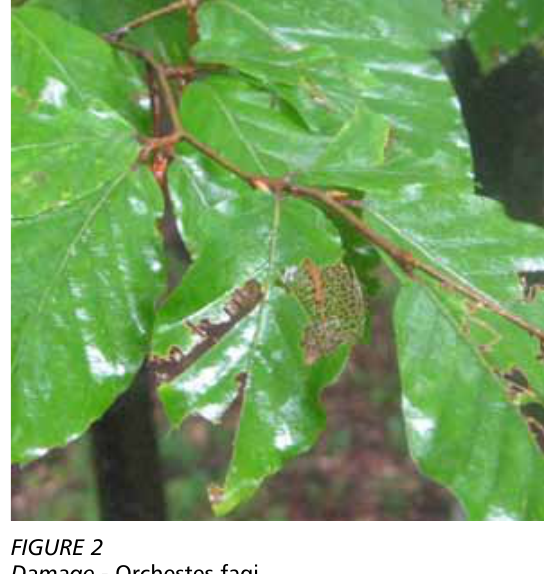
FIGURE 2 Damage - Orchestes fagi